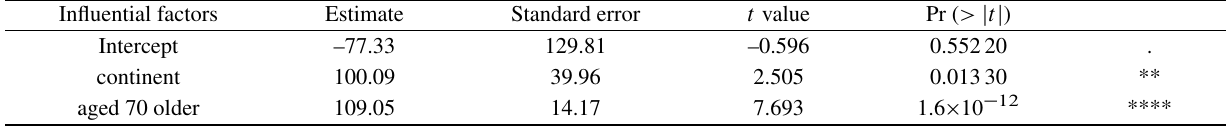
Table 4A Multiple linear regression model with TDPM as the dependent